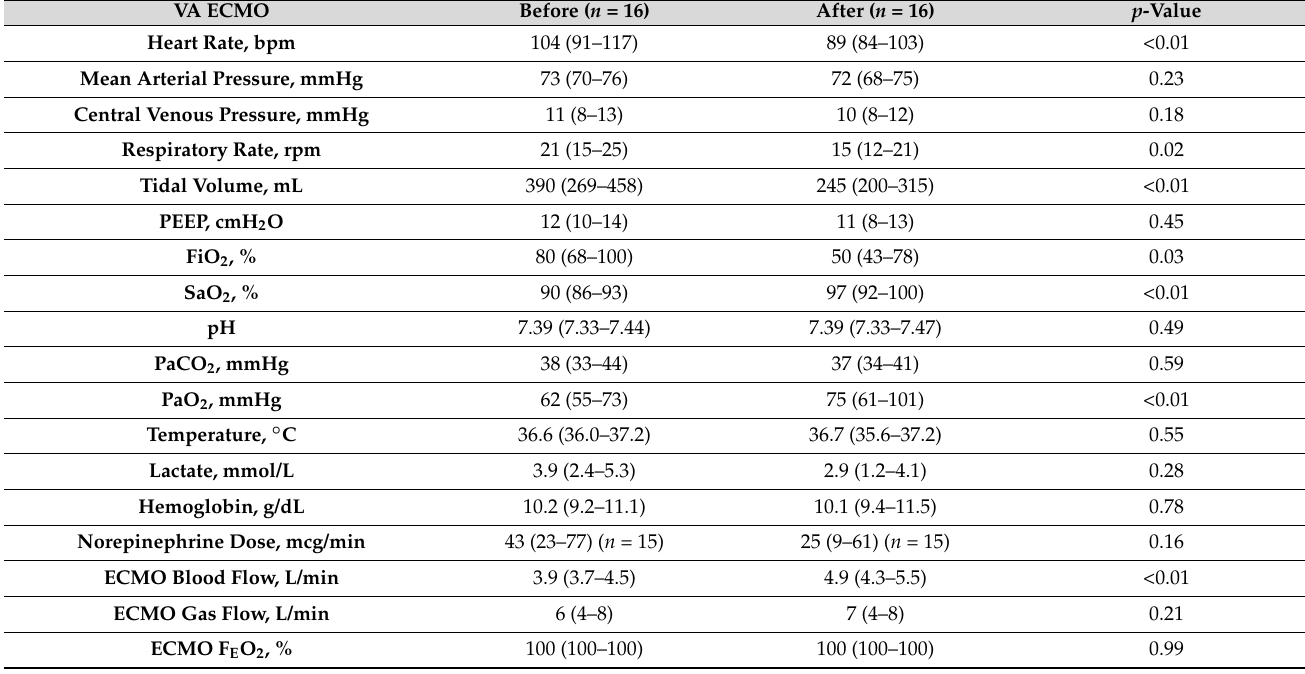
Figure 1. Significant changes in different variables before and after the implementation of V-AV ECMO in patients ( n = 16) with initial VA-ECMO configuration. Table 3. Changes in all measured variables before and after V-AV ECMO implementation, according to the initial ECMO configuration (VA = veno-arterial; VV = veno-venous). Data are presented as median [IQRs].